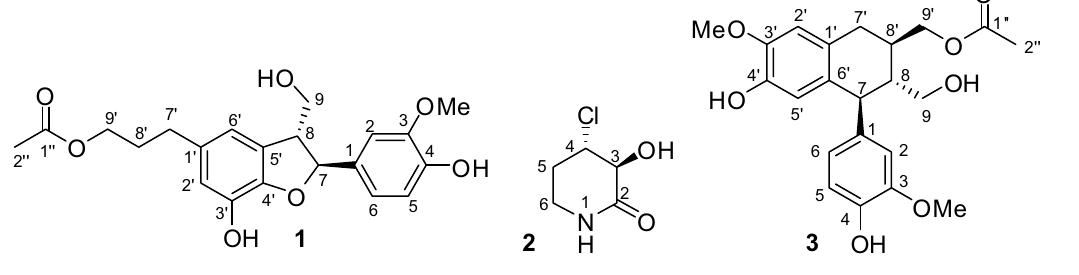
Fig. 1 Chemical structures of compounds 1 – 3 from Leea